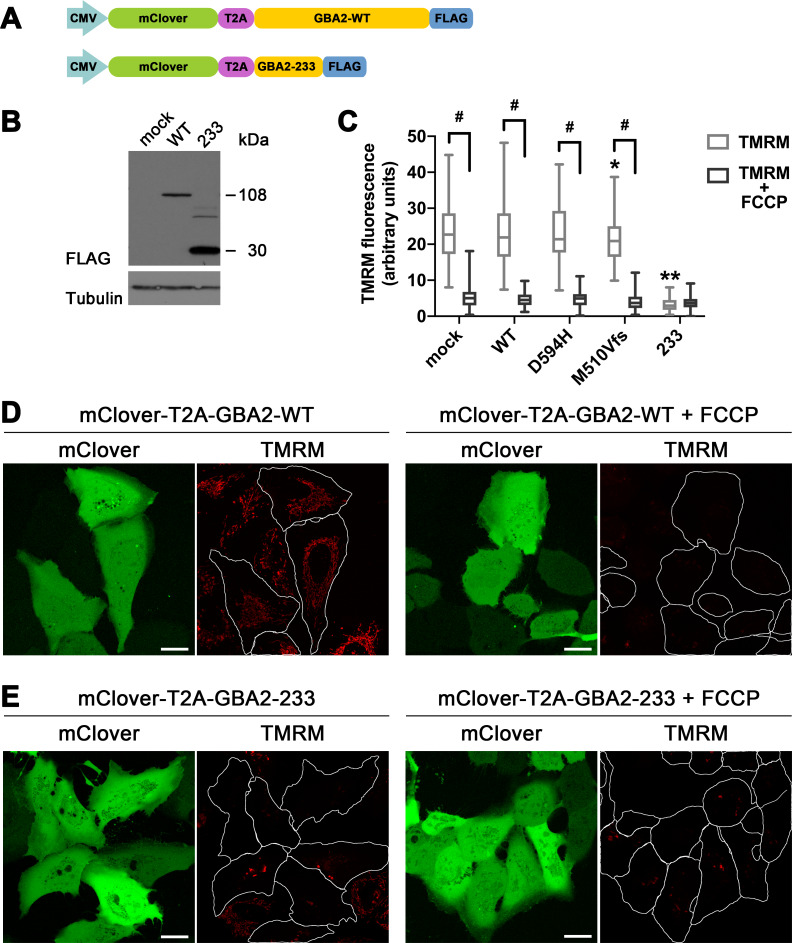
GBA2-233 depletes the mitochondrial transmembrane potential.(A) Schematics of cDNA constructs allowing the co-expression of mClover and WT or GBA2-233. Similar constructs were used for the co-expression of mClover and GBA2-D594, GBA2-M510Vfs*17. (B) Western blot prepared with lysates from U2OS cells transfected with the constructs depicted in [A] probed with an anti-FLAG antibody; apparent molecular weights are indicated. (C) Quantification of transmembrane potential in non-transfected cells and in cells expressing GBA2-WT, GBA2-D594, GBA2-M510Vfs*17, and GBA2-233 (30 cells were analyzed for each of three independent experiments; whiskers, 1–99 percentile). Fluorescence intensity was quantified after exposure of cells to TMRM. Statistical comparisons for the impact of FCCP, using one-way nested ANOVA: #, P < 0.0001. Statistical comparisons with GBA2-WT: *, P = 0.0488; **, P < 0.0001. (D) Non-transfected cells and cells co-expressing mClover (green) and GBA2-WT were imaged live by confocal microscopy after exposure to TMRM (red) (left two panels) or TMRM and FCCP (right two panels). (E) Non-transfected cells and cells co-expressing mClover (green) and GBA2-233 were imaged live by confocal microscopy after exposure to TMRM (red) (left two panels) or TMRM and FCCP (right two panels). Scale bar, 20 μm.